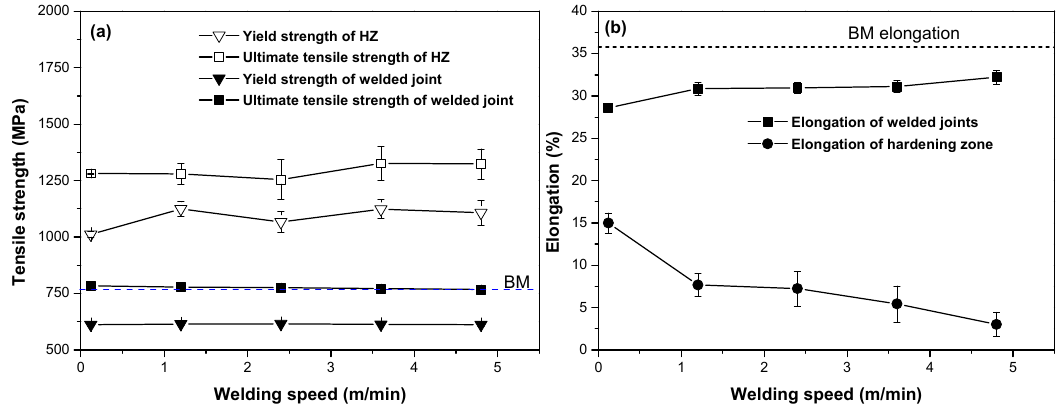
Figure 7. The mechanical properties of ( a ) ultimate tensile strength (UTS) and yield strength (YS); ( b ) elongation of the welded joints and HZ.